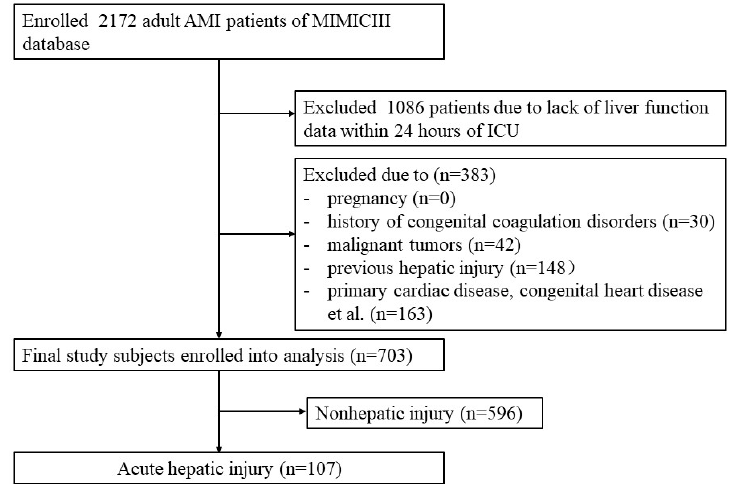
Figure 1. Flowchart of the enrolled patients.